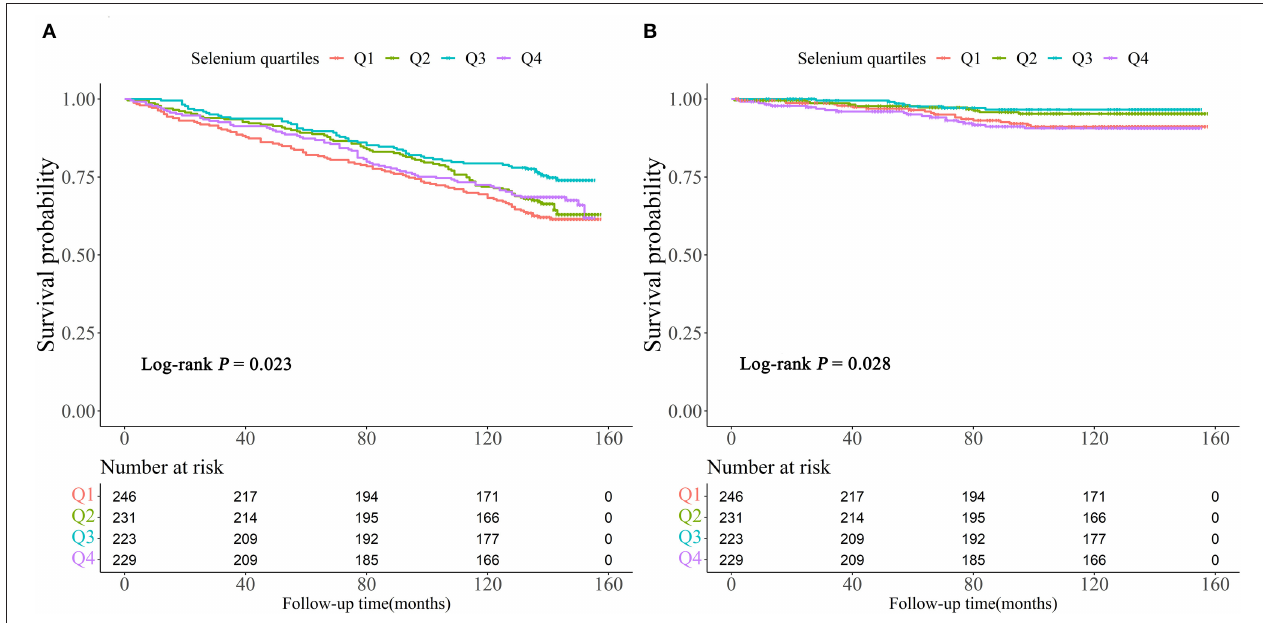
FIGURE 3 | Kaplan-Meier survival curve for all-cause (A) and cardiovascular mortality (B)